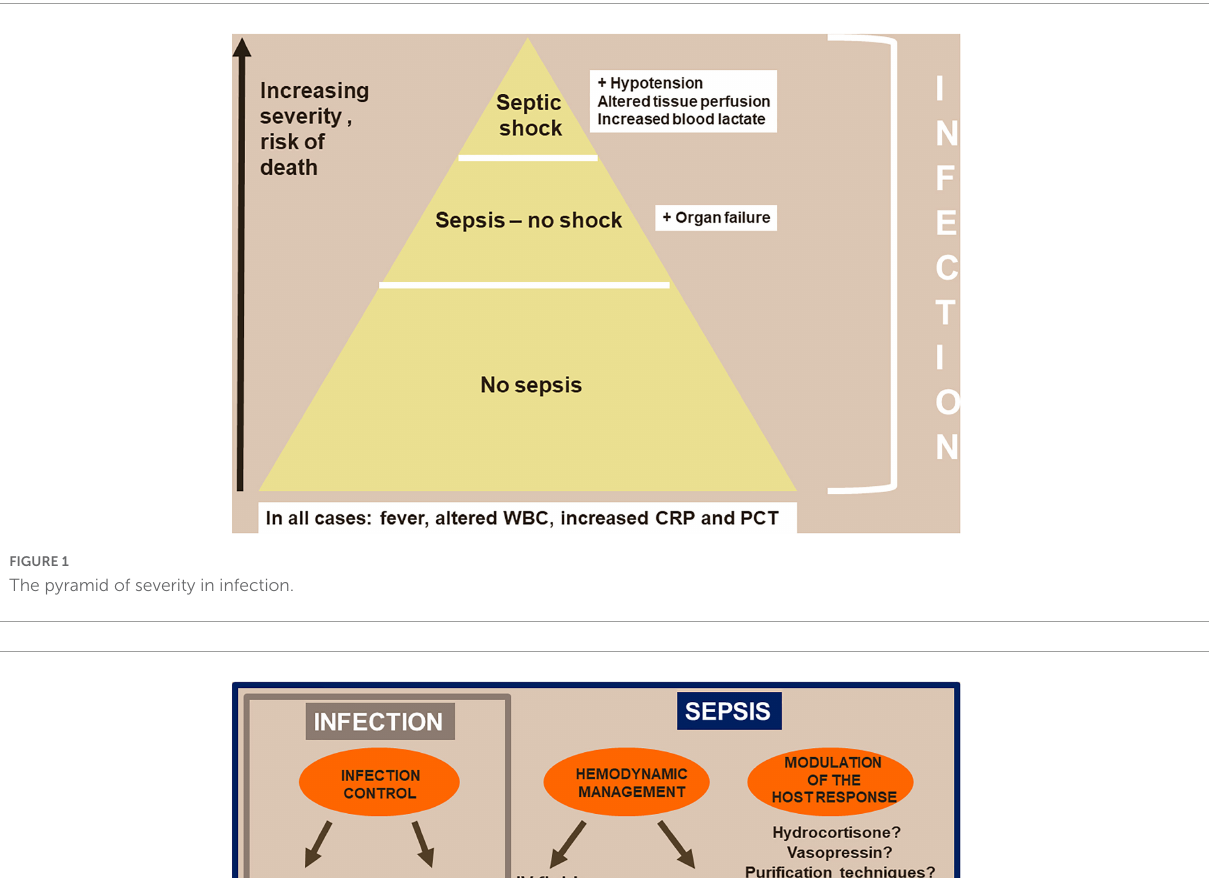
FIGURE2 Factors of management of infection (small rectangle) and sepsis (large